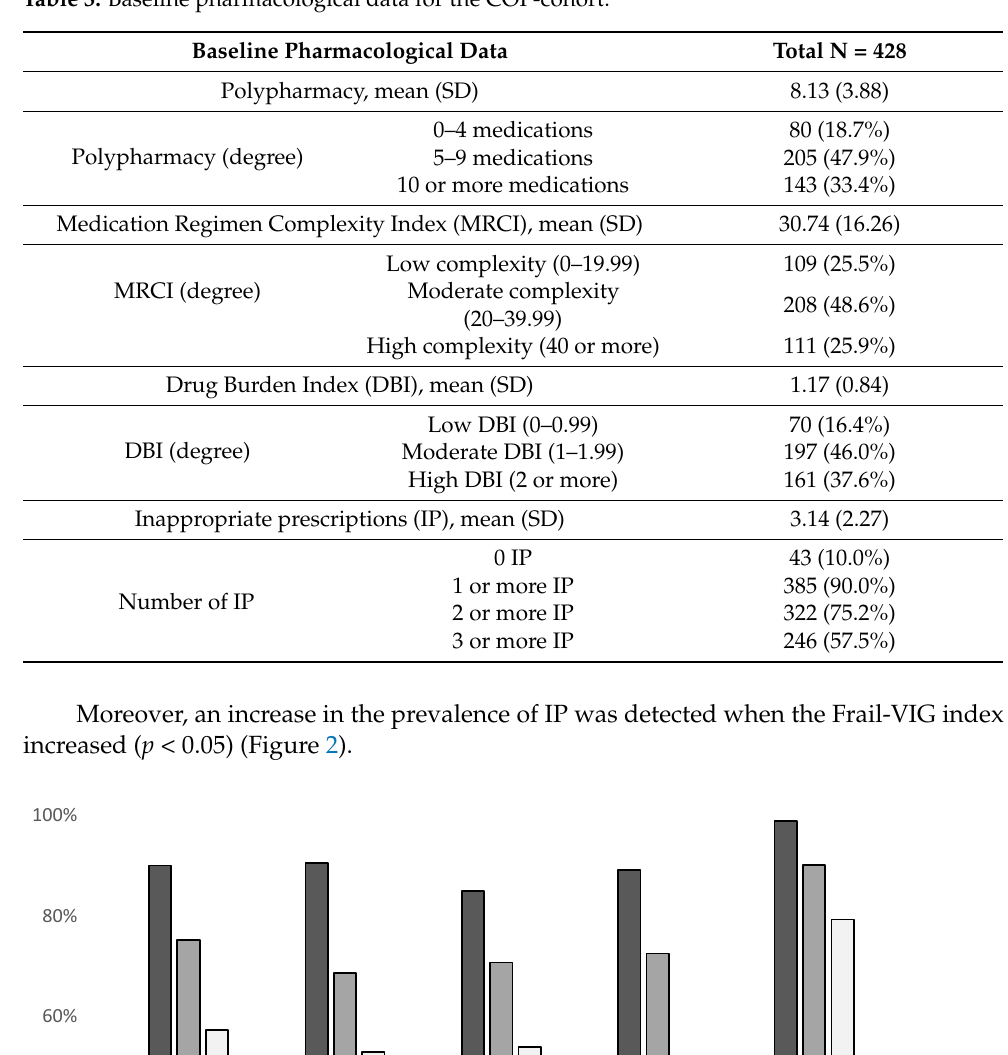
Table 3. Baseline pharmacological data for the COP-cohort.